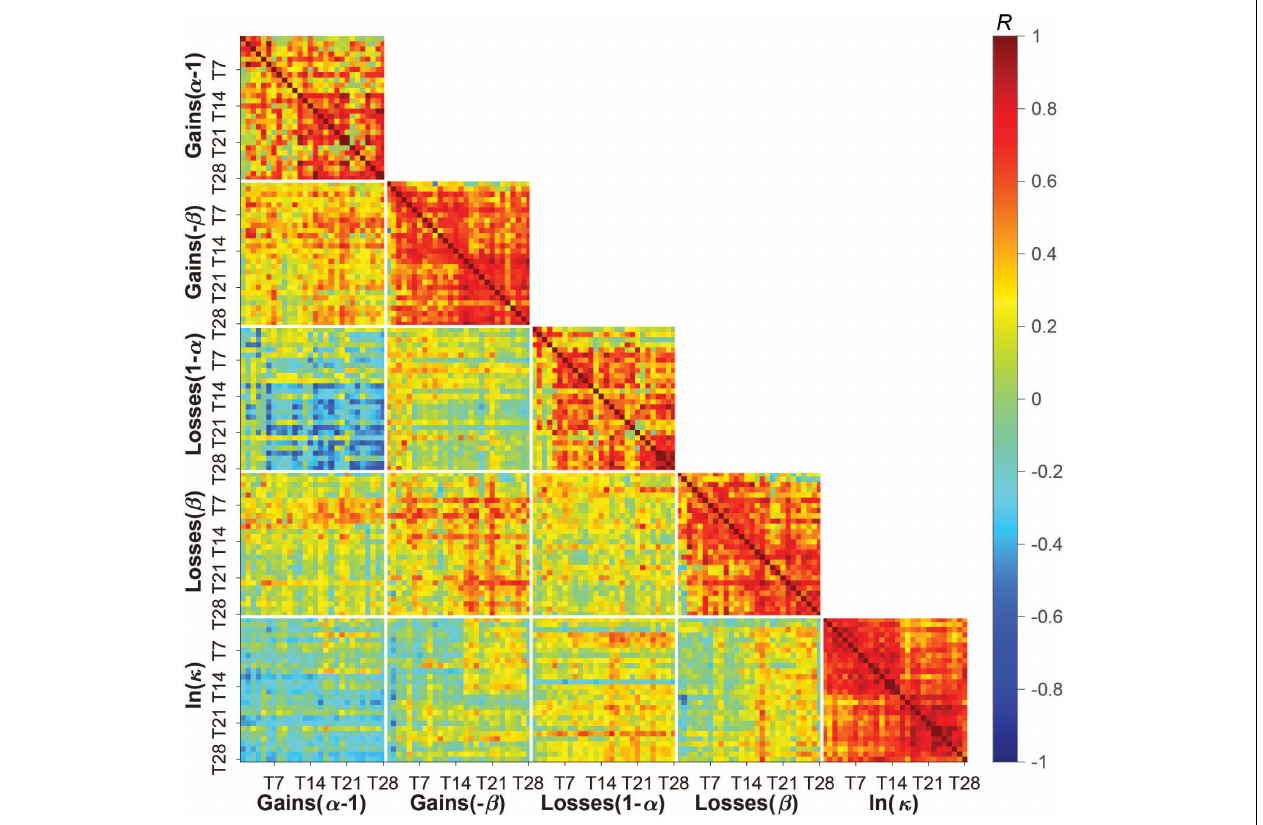
FIGURE 3 | Pairwise correlations between and within task parameters across all study days and subjects. Subjects’ risk, ambiguity, and discounting parameters were only weakly to moderately correlated with each other across subjects and days (blue/green tiles away from the identity line) but moderately to strongly correlated with themselves across study days (red tiles near the identity line). Low to moderate correlations between parameters indicate some degree of independence across these measures of a person’s decision-making profile. Moderate to high correlations within parameters (i.e., day-to-day correlations) suggests reasonable test-retest reliability, which was also measured by the intraclass correlation coefficient (see section “Results”) and found to differ somewhat across parameters (with discounting having the highest reliability/lowest within-person variability). Color bar shows Pearson’s R [–1,1].